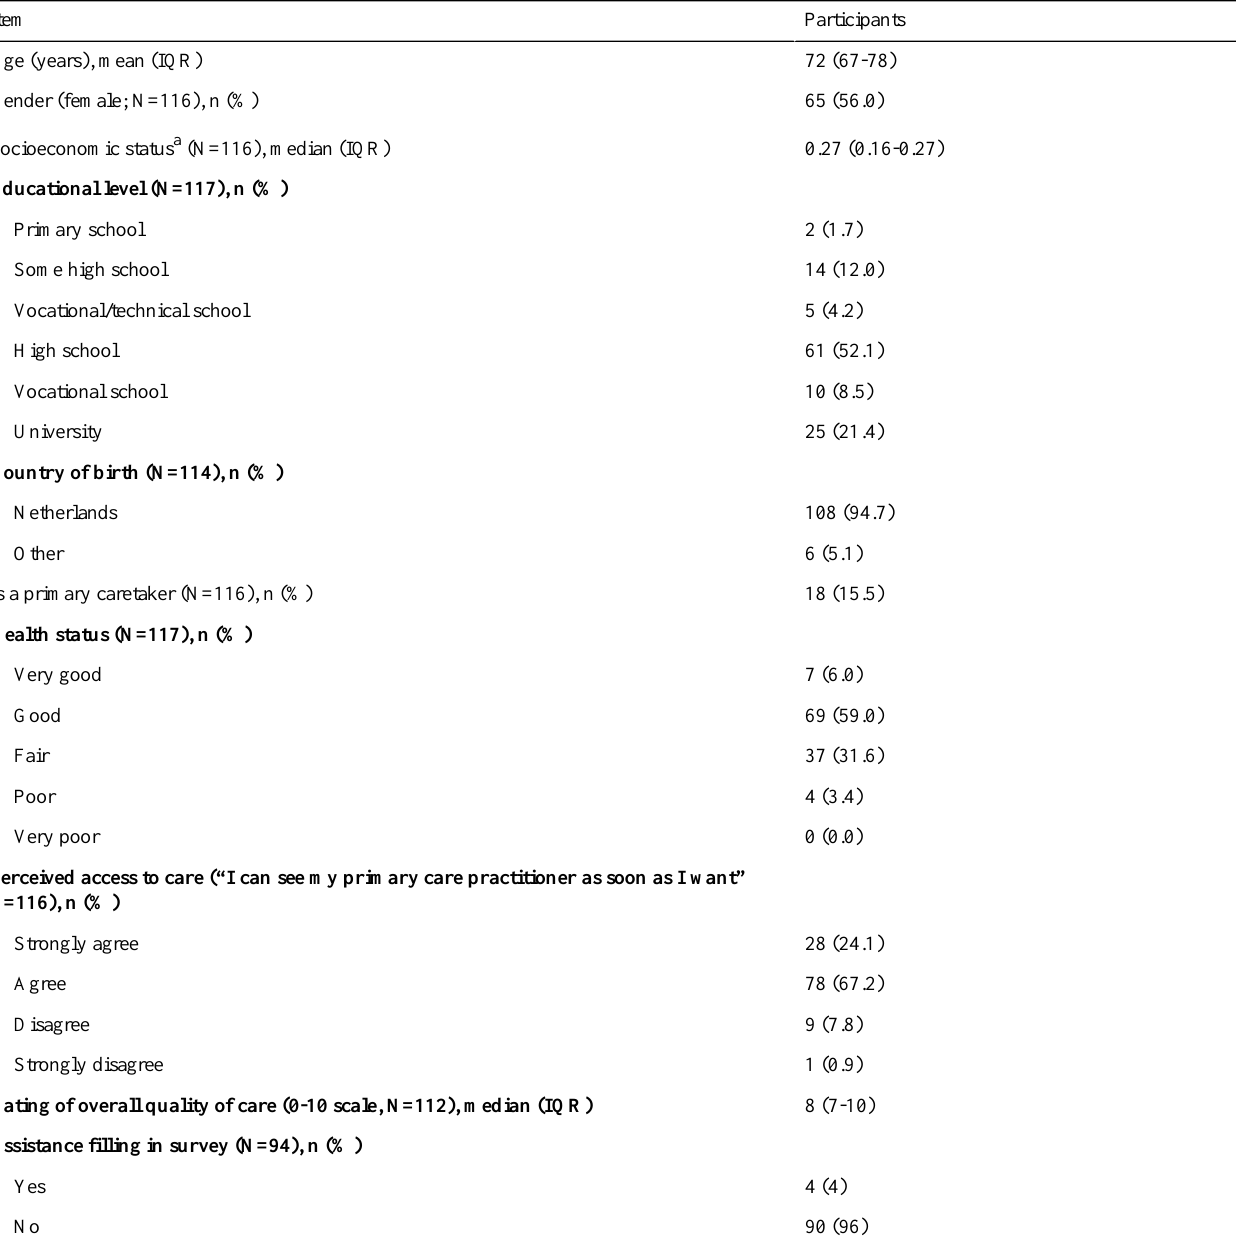
Table 1. Demographics of respondents in the survey